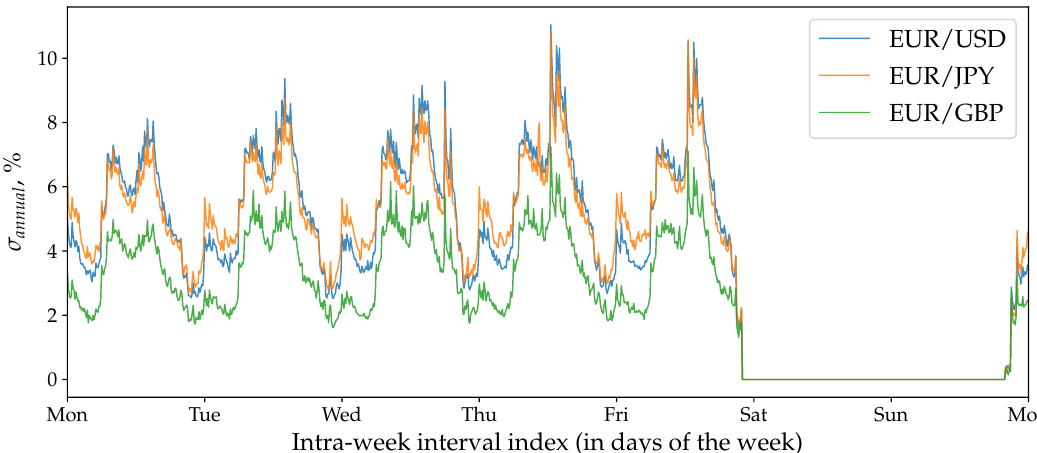
Figure 6. Instantaneous volatility seasonality of three Forex (FX) exchange rates computed using the directional-change approach (Equation (19)). Applied directional-change threshold δ = 0.01%. The whole week is divided by equally spaced time intervals T = 10 min (1008 bins in